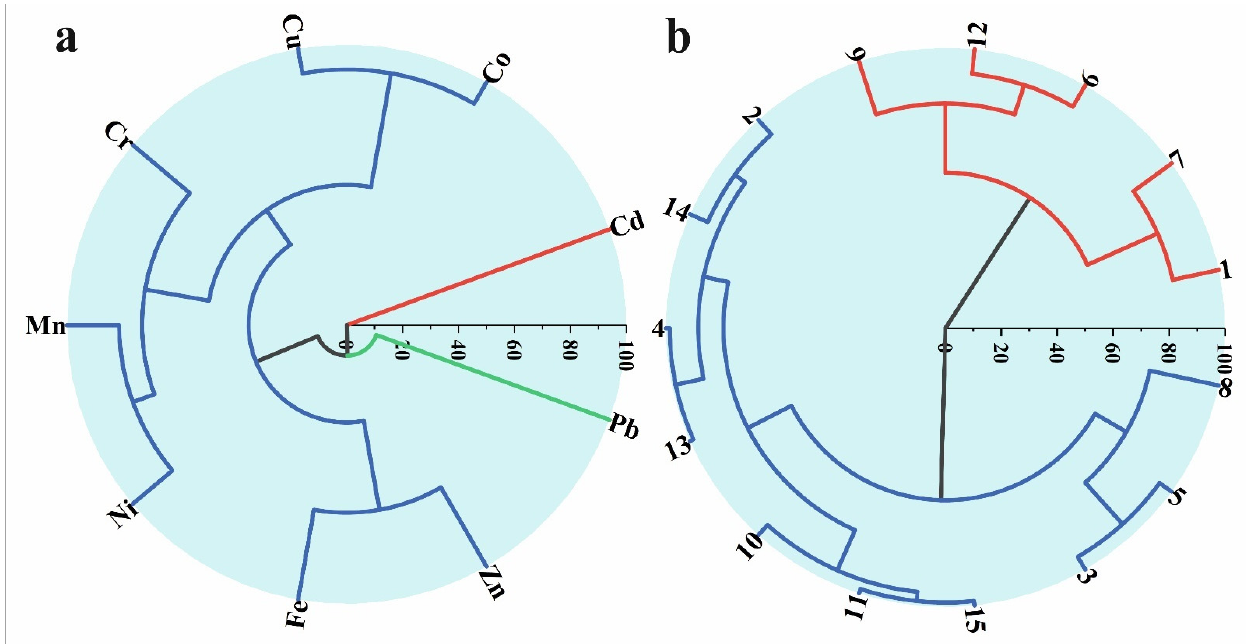
Figure 4. CA dendrogram ( a ) R-mode (Variables); ( b ) Q-mode (Sampling sites).